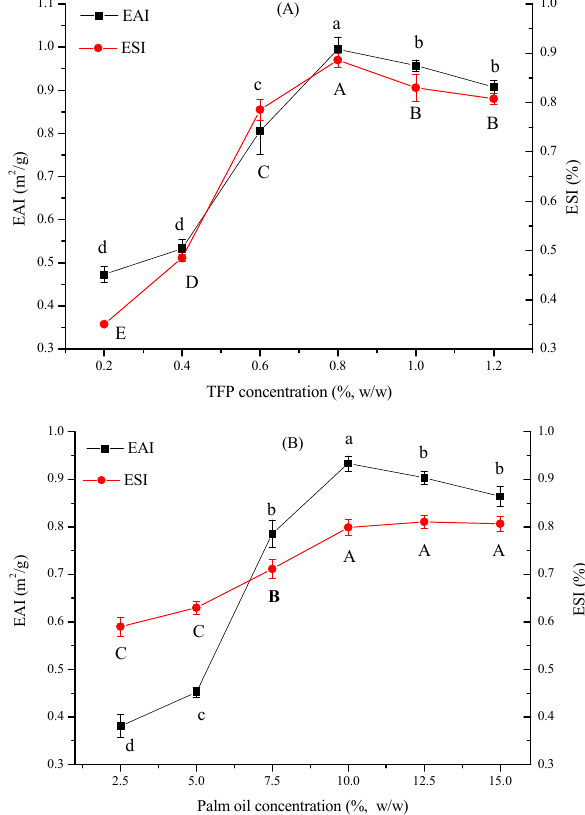
Figure 1. Effect of TFP ( A ) and oil ( B ) concentration on EAI and ESI. (Different lowercase and uppercase letters indicate a significant difference between EAI and ESI at p < 0.05).